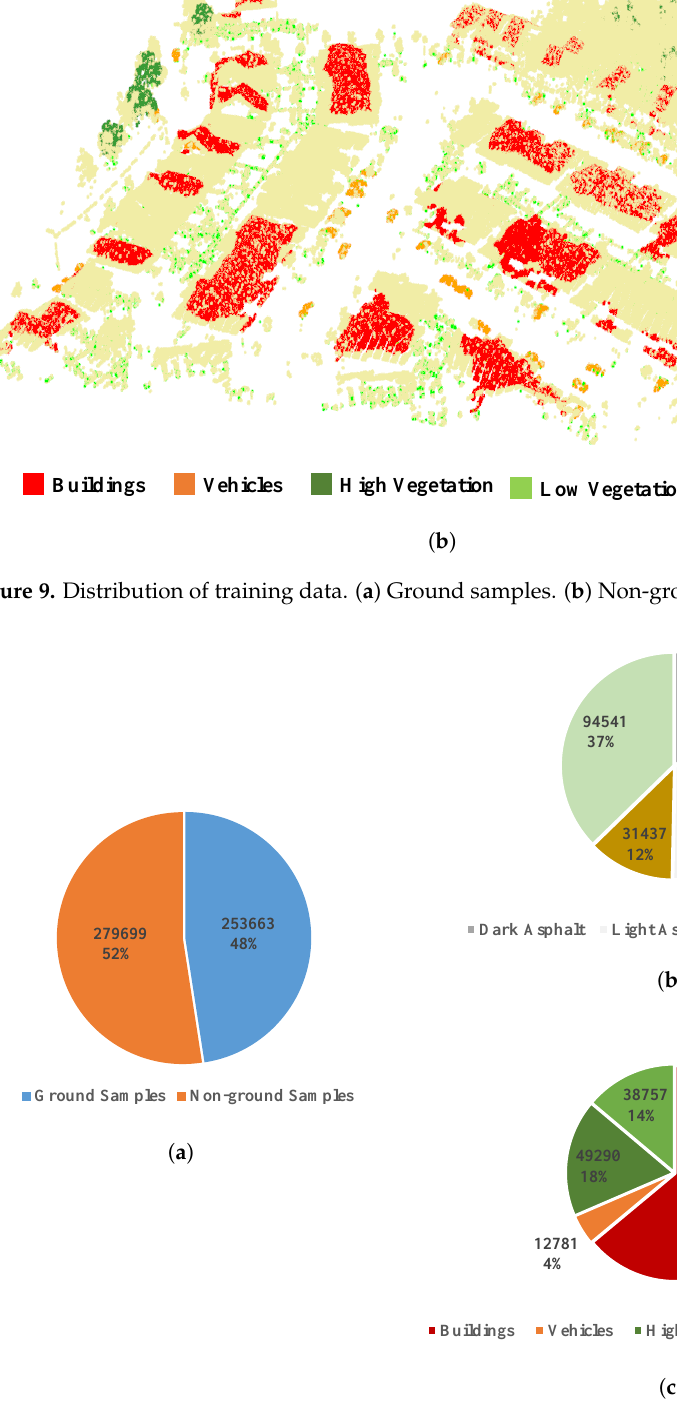
Figure 10. Breakdown of training data. ( a ) Total samples. ( b ) Ground samples. ( c ) Non-ground